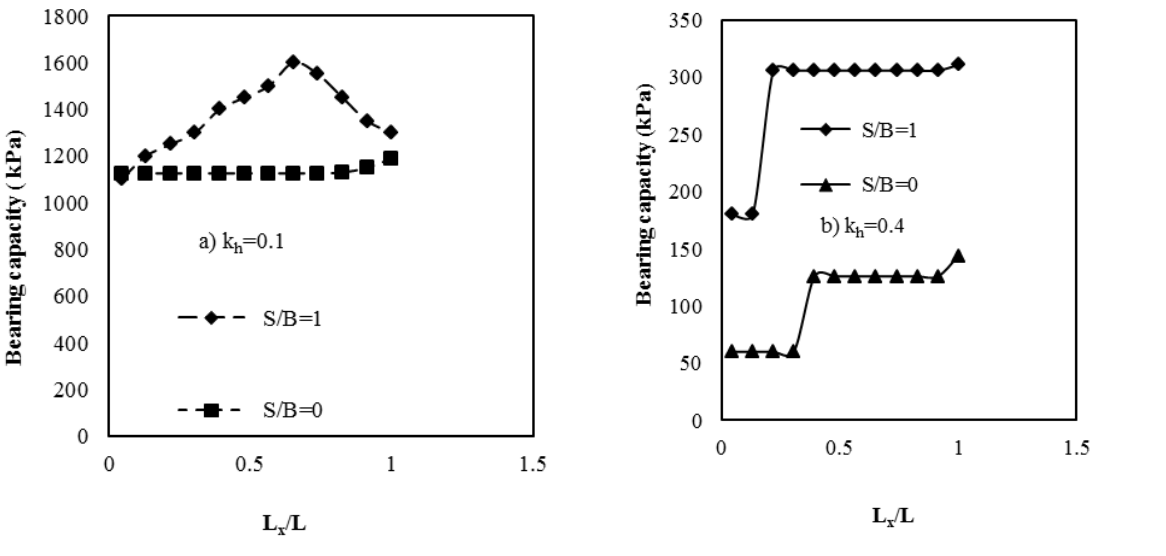
Fig. 7. Effect of footing distance, relative to slope crest on footing seismic bearing capacity for various locations of